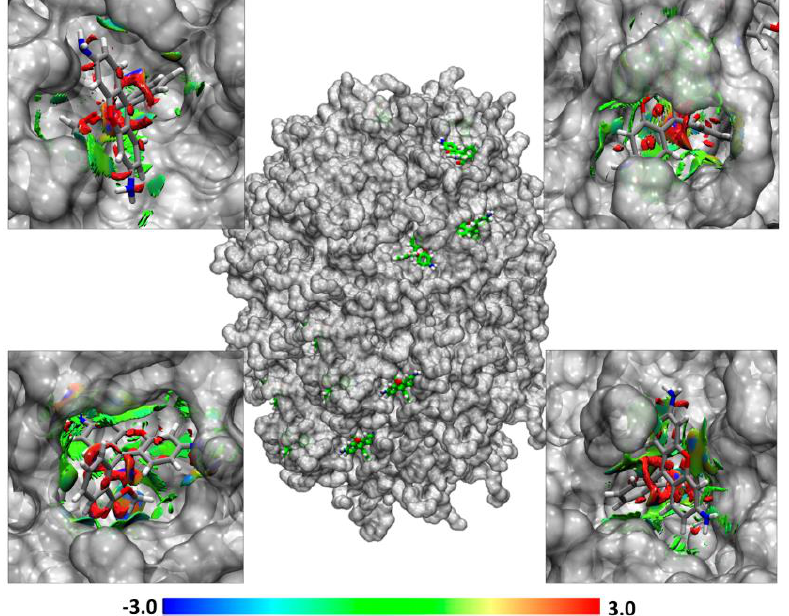
Figure 11. NCIPLOT isosurface gradient (0.6 au) between Rhodamine 123 and mixed NLC of Miglyol ® 812, Tween ® 80 and Gelucire ® 44/14. The surfaces were colored on a blue-green-red scale according to the strength and type of interaction. Blue indicates strong attractive interactions, green indicates weak Van der Waals interactions, and red indicates a strong non-bonded overlap.